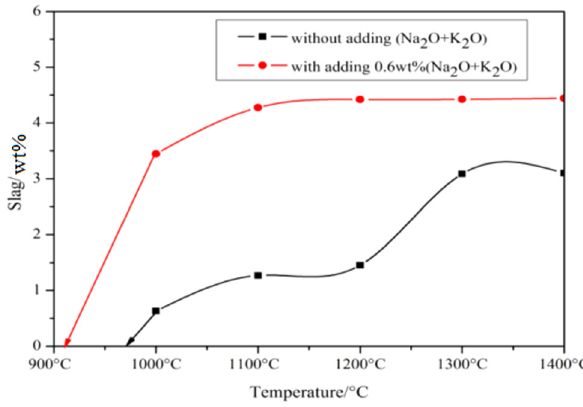
Figure 10: Calculating the liquid phase curve using